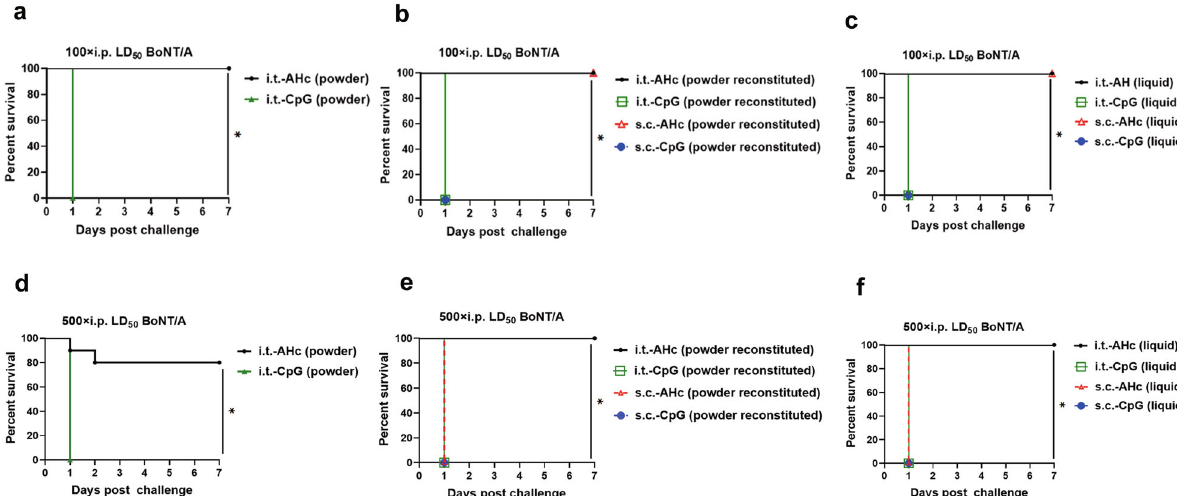
Fig. 6 BAL from i.t.-AHc-immunized mice neutralized the toxicity of 100× i.p. LD 50 or 500× i.p. LD 50 before challenge via the i.p. route. BoNT/A was incubated with BAL from AHc-immunized mice in PBS (1:1) for 30 min at room temperature. a , d BAL from dry powder formulation-immunized mice. b , e BAL from reconstituted powder formulation-immunized mice. c , f BAL from liquid formulation-immunized mice. Then mice were challenged with a – c 100× i.p. LD 50 ( n = 5) or d – f 500× i.p. LD 50 ( n = 10) of BoNT/A that had been preincubated with BAL from different groups. The animal survival rate was analyzed by Kaplan – Meier survival estimates. * P <